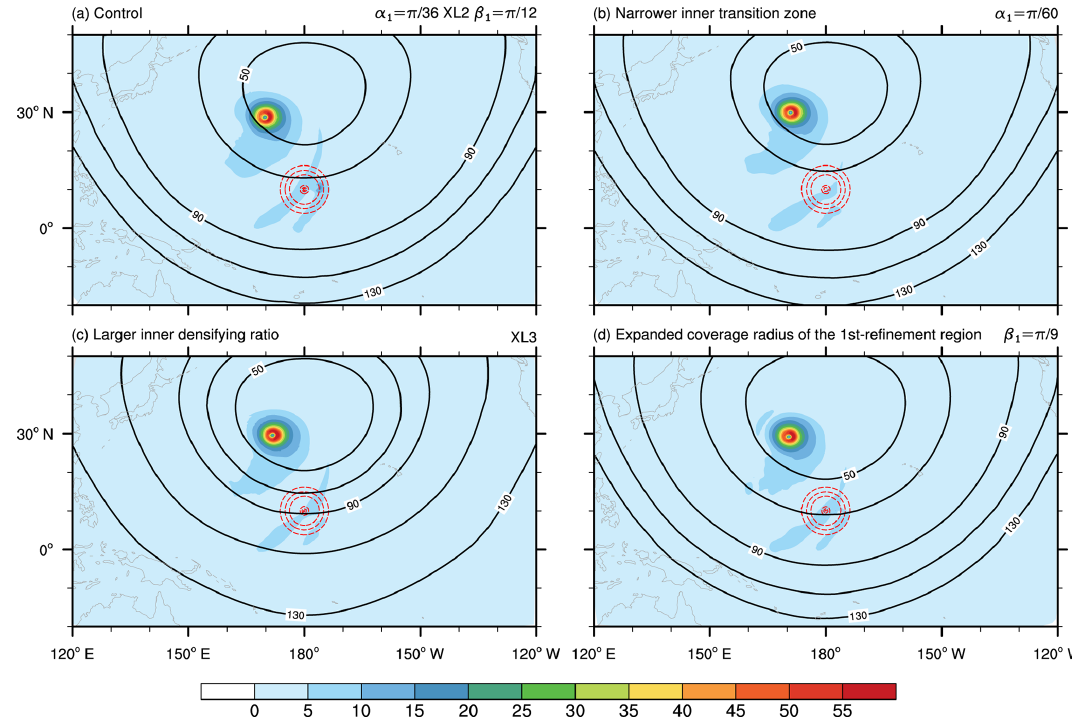
Figure 9. Idealized tropical cyclone test. The horizontal wind speed (ms − 1 ) at 850hPa after 10 simulation days based on hierarchical refinement meshes with (a) the control, (b) reduced α 1 and (c) higher λ for more rapid changes in the transition zone, and (d) larger β 1 to make the transition zone affect the tropical cyclone in an earlier stage. The red dashes denote the initial location of the tropical cyclone. The contour lines denote the smoothed mesh cell sizes